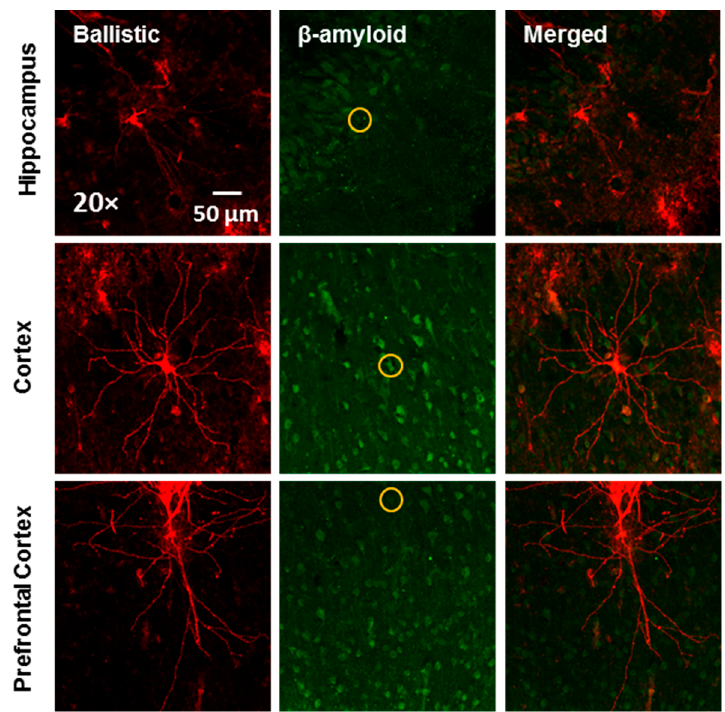
Figure 2. Co-localization of DiOlistically labeled neurons and β -amyloid immunostaining in the hippocampus, cortex, and prefrontal cortex. The yellow circle indicated the DiOlistically labeled neuron co-localizing with β -amyloid immunostaining positive signal